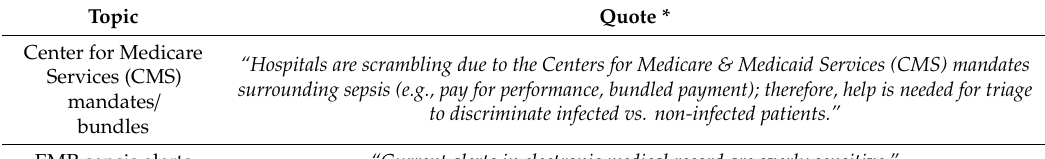
Table 1. Key quotes from advisory panel